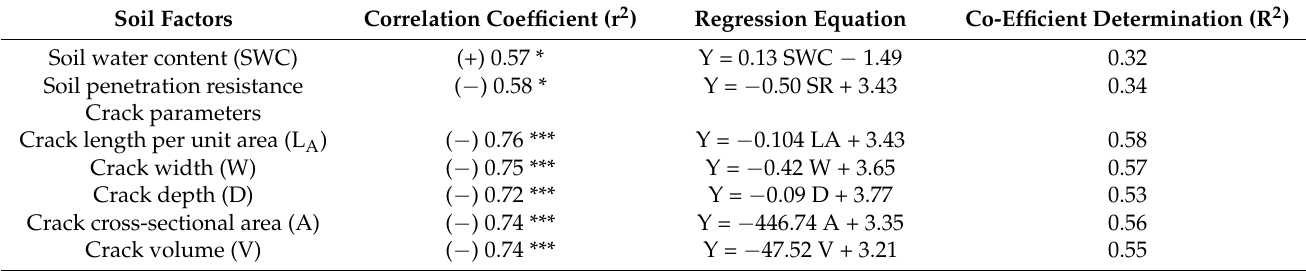
Table 3. Relationship between yield and soil factors (soil water content, soil penetration resistance and crack parameters). Soil Factors Correlation Coefficient (r 2 ) Regression Equation Co-Efficient Determination (R 2 )